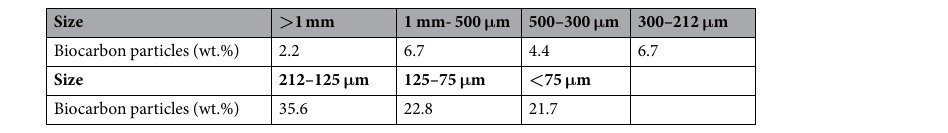
Table 4. Particle size distribution by mass percent for biocarbon.